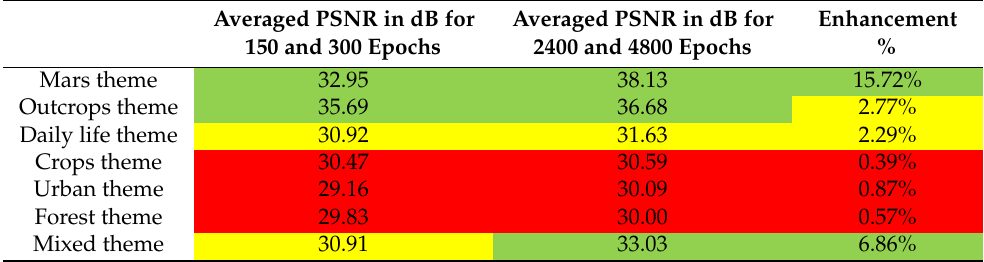
Table 2. Average PSNRs were obtained for 150 and 300 epochs, and then for 2400 and 4800 epochs. The increase in these average PSNRs is expressed as a percentage of the values in the first column. The colours highlight groups of values of the same order of